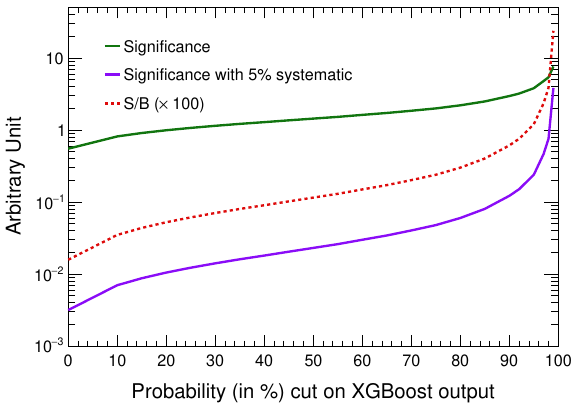
Figure 4 . The variation of significance (with ( 5% ) and without systematic uncertainty) and S/B is shown as a function of the probability cut on the XGBoost output for the b ¯ bτ + τ −